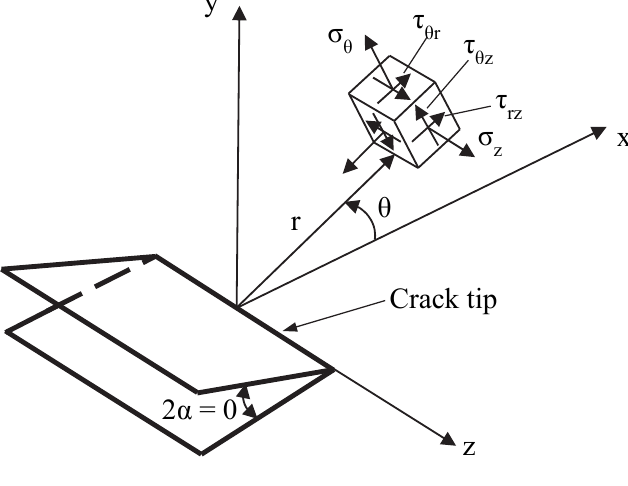
Figure 2: Notation for crack tip stress